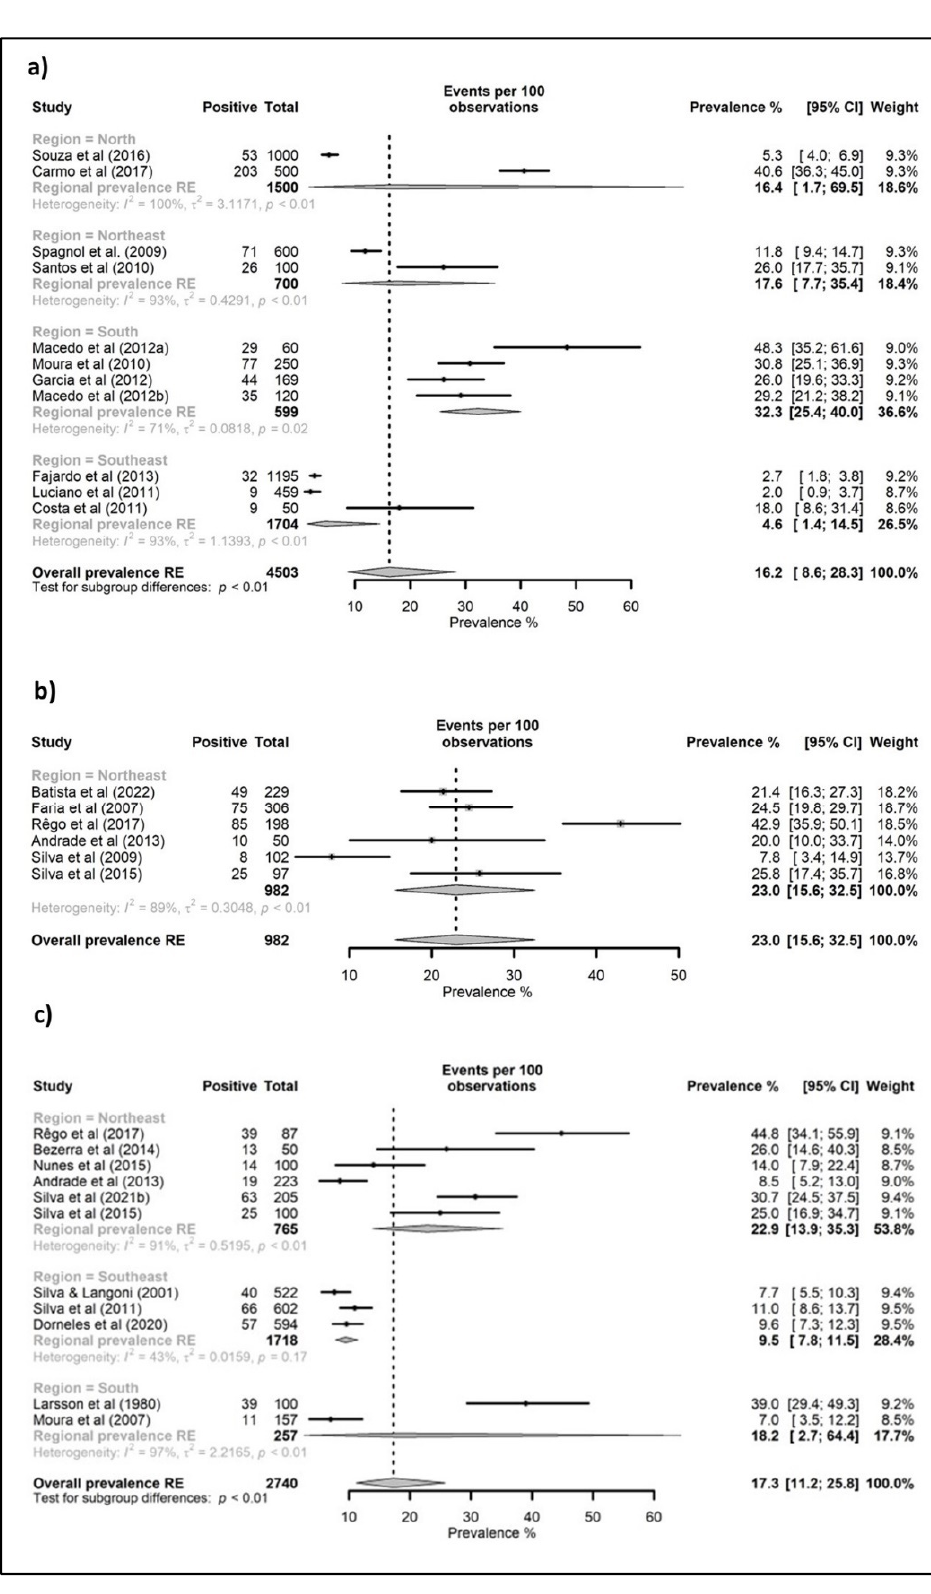
Figure 4. Forest tree of studies reporting toxoplasmosis prevalence in ruminants slaughtered for human consumption in Brazil, grouped by administrative region. ( a ) Cattle, ( b ) goats, and ( c ) sheep. C.I: confidence interval; RE: random